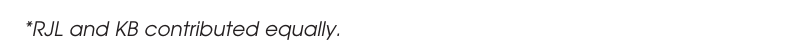
arthritis (4–8). High levels of TNF also were detected in the wound fluid of chronic nonhealing wounds and induce cytotoxicity